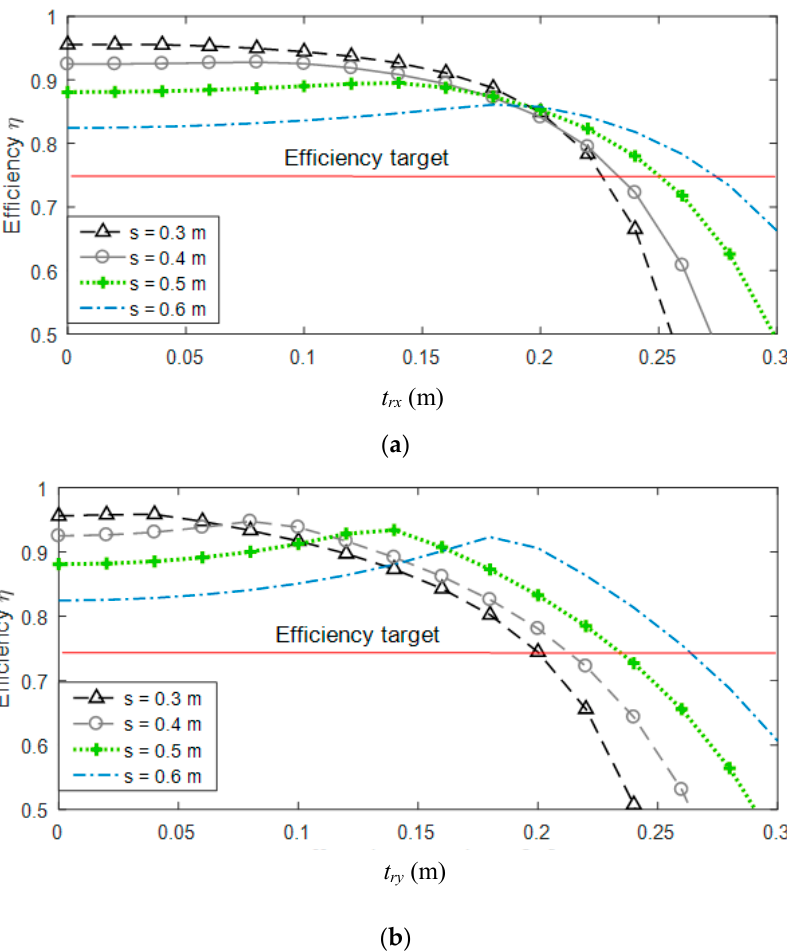
Figure 6. Efficiency η vs. lateral misalignment (offset) t rx ( a ) and t ry ( b ) for variable side length s of the transmitting coil.